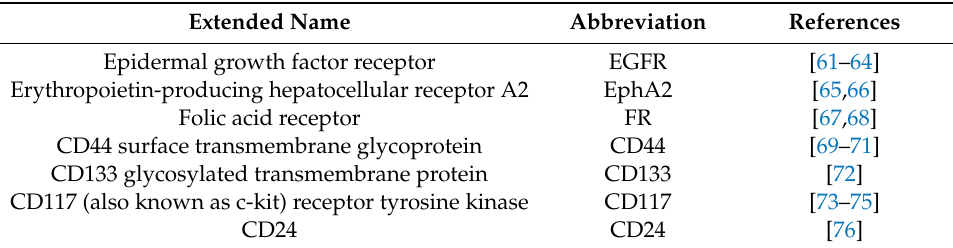
Table 1. Specific surface antigens on OC